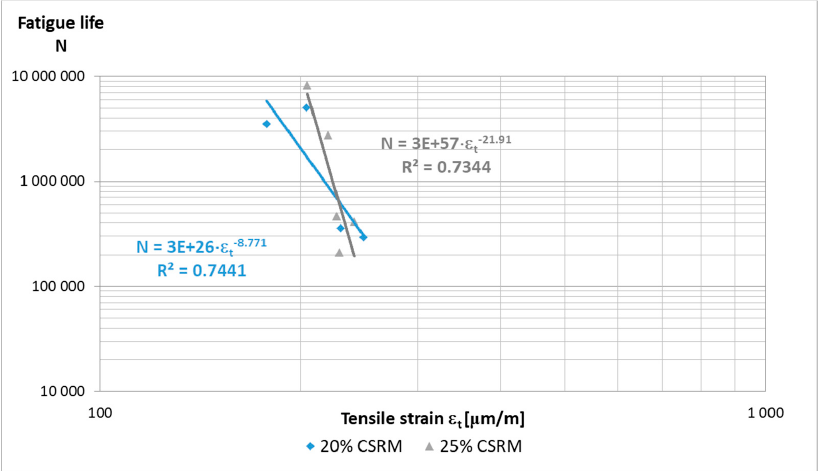
Figure 11. Fatigue life of ACCR with “B” CSR mortar beams 380 mm × 63 mm × 50 mm at 10 °C, after 28 days of curing.